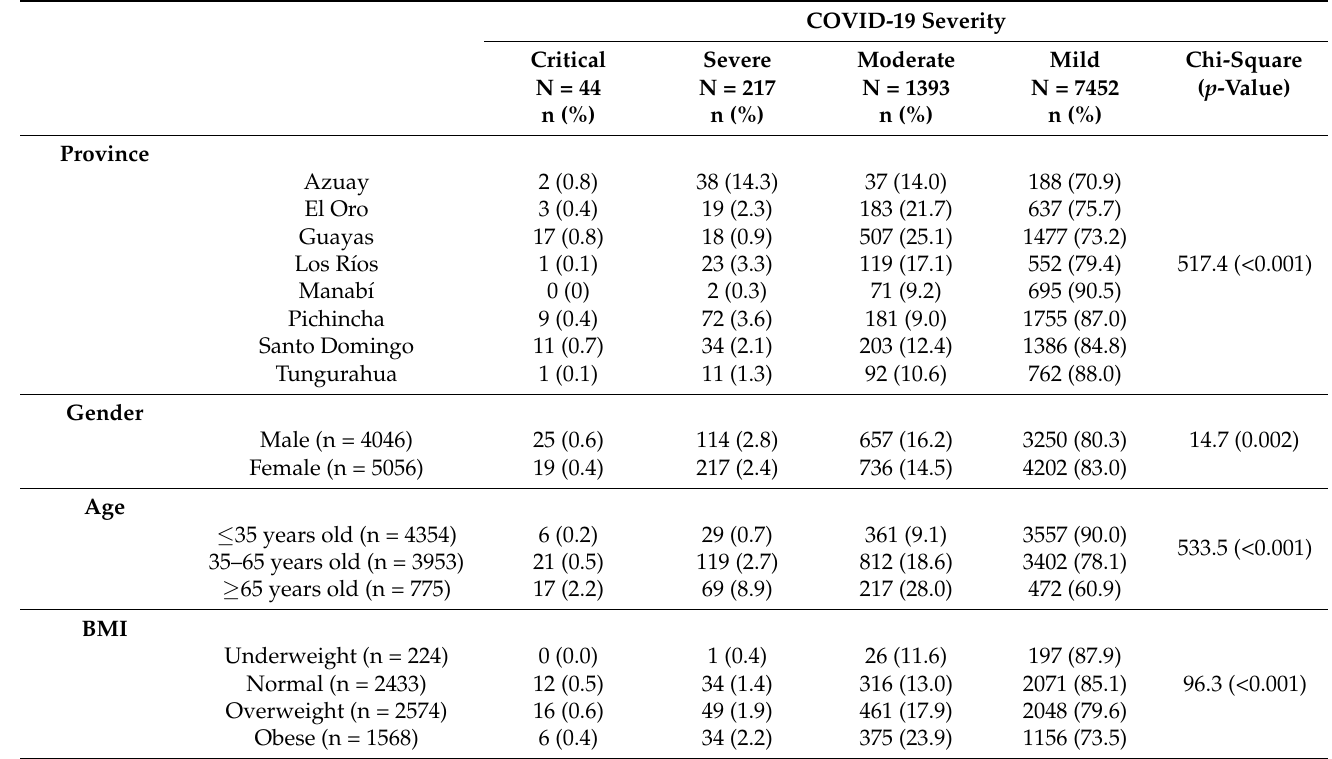
Table 3. Severity level according to sociodemographic